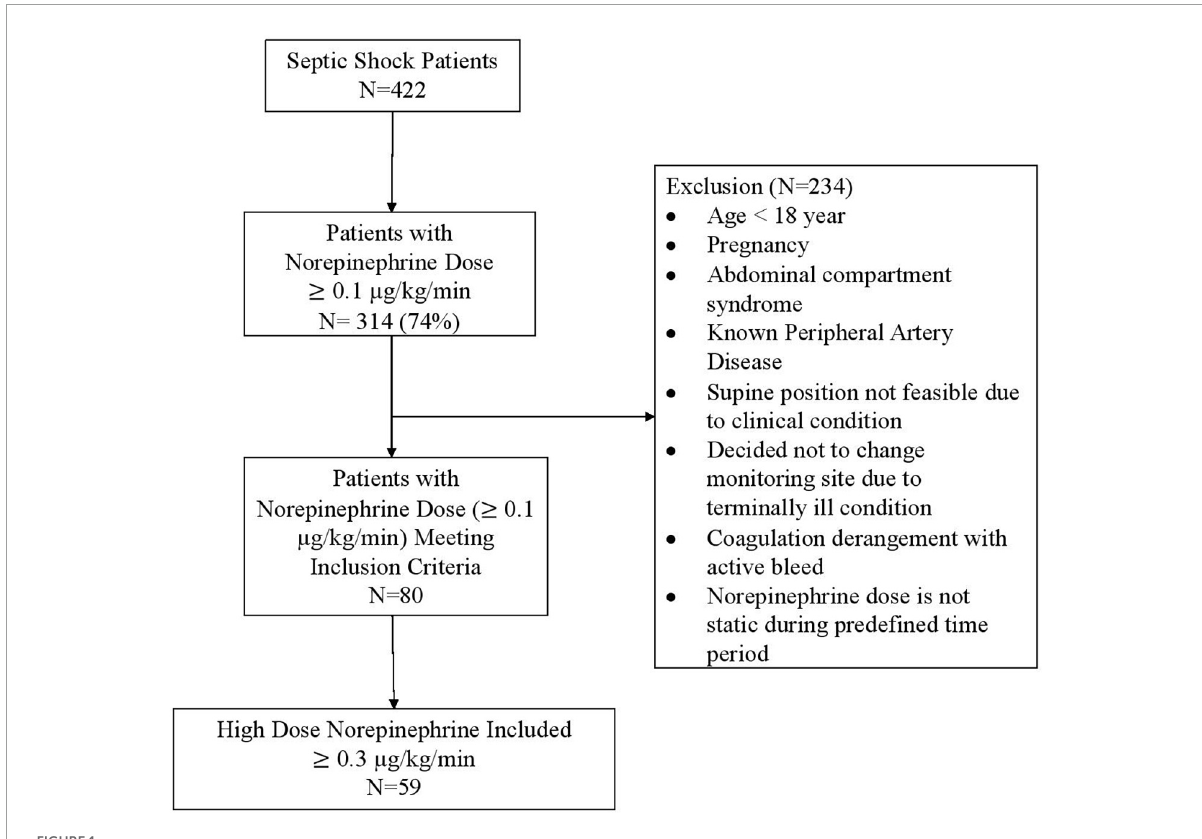
FIGURE1 Patients included in the study.